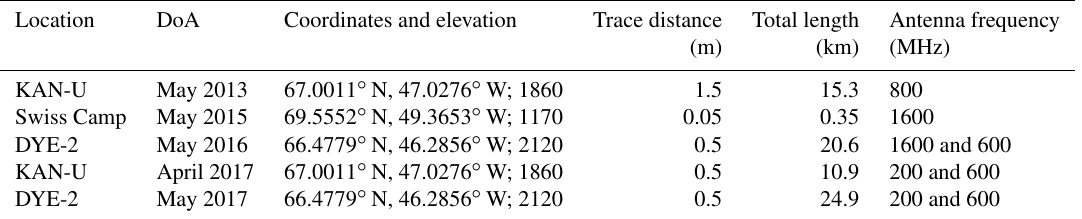
Table 1. Metadata for the five GPR transects analyzed in this study. Coordinates are presented in geographical coordinates with elevation in meters above sea level (ma.s.l.). DoA is date of